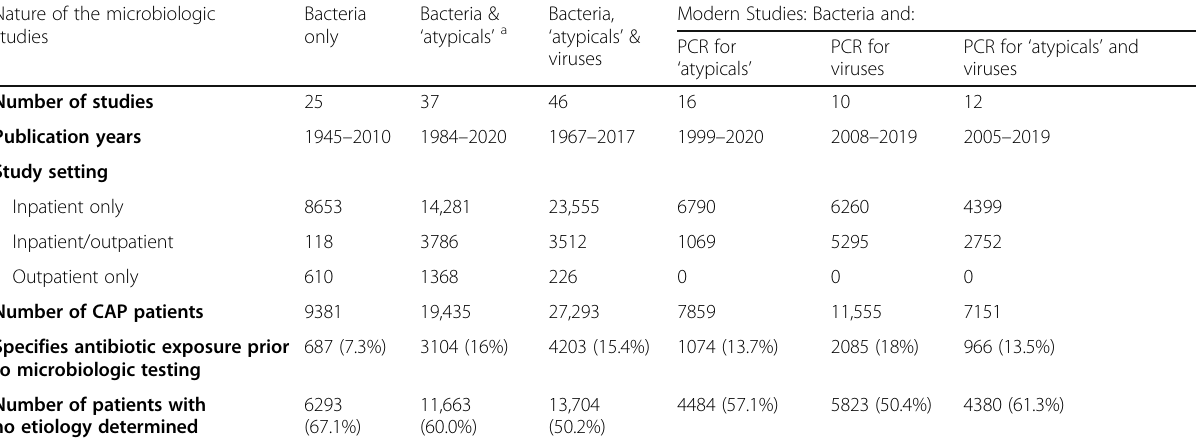
Table 1 Characteristics of studies reporting the etiology of community acquired pneumonia (CAP) Nature of the microbiologic